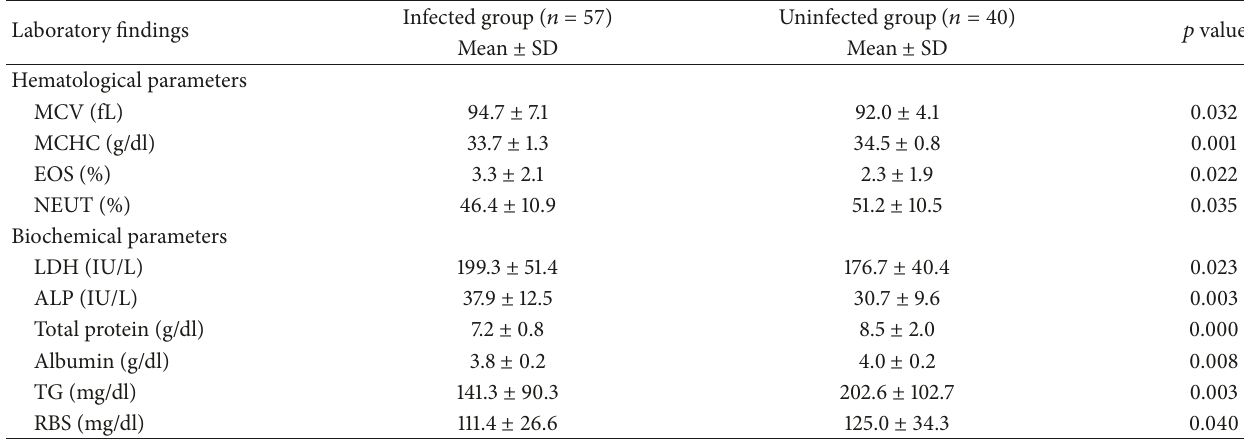
Table 5: Comparison of laboratory findings between C. sinensis infected and uninfected